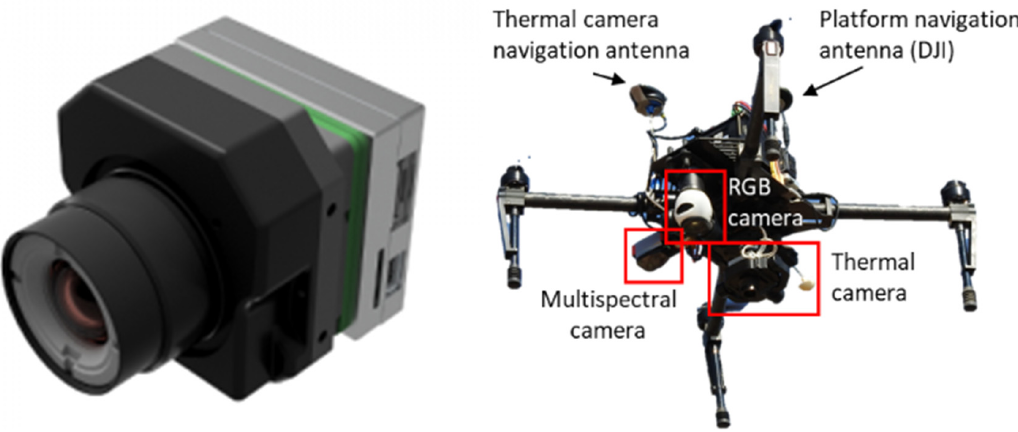
Figure 2. TeAx ThermalCapture 2.0 camera ( left ) mounted on the DJI Matrice 100 along with red-green-blue (RGB) and multi-spectral cameras ( right ).